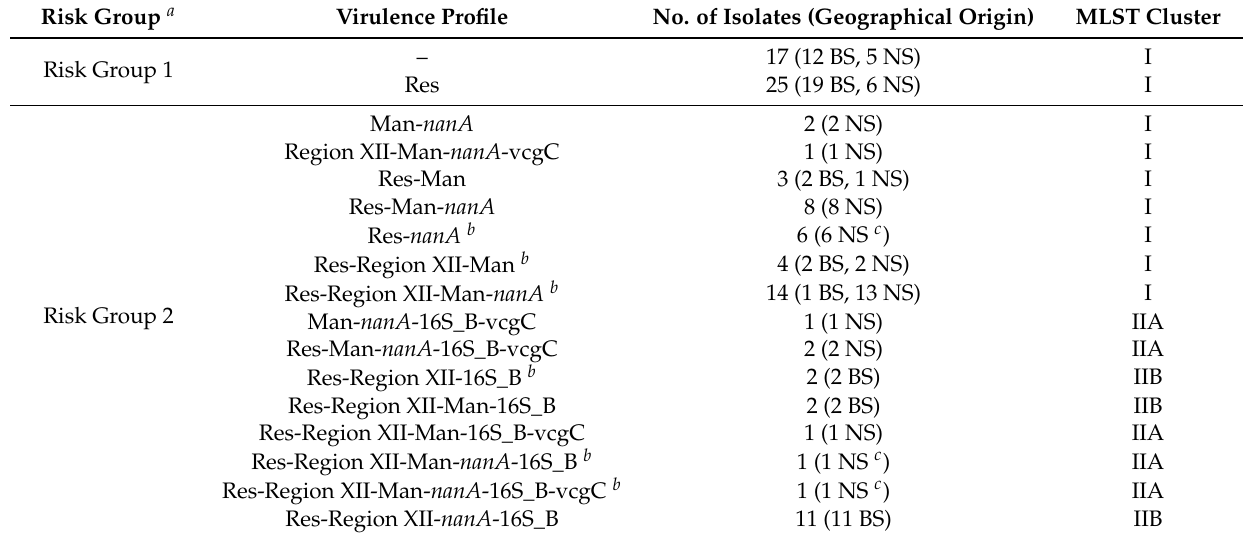
Table 2. Virulence profiles and corresponding number of V. vulnificus strains with respect to geographical origin and MLST